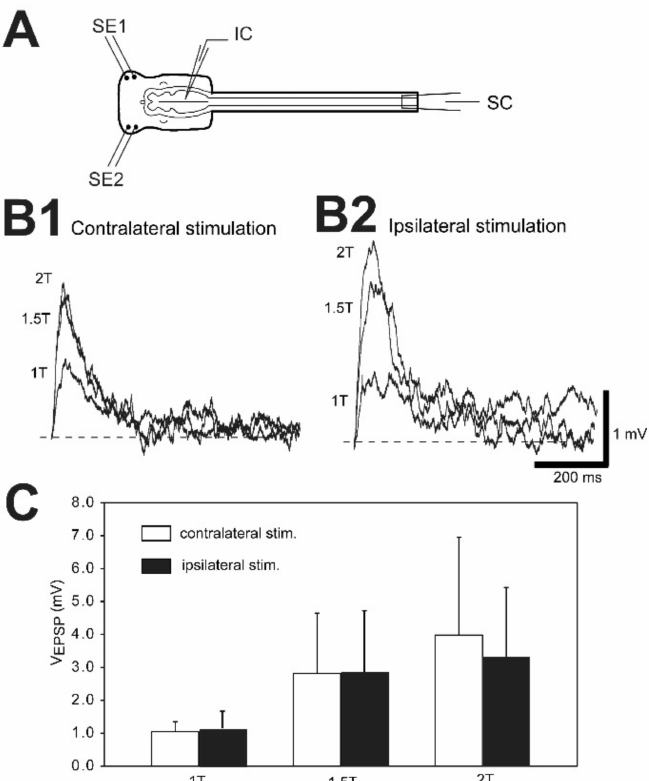
Figure 8. Comparison of contralateral vs. ipsilateral sensory-evoked EPSPs for RS neurons in normal animals. ( A ) Diagram of in vitro brain-spinal cord preparation (not to scale) from a normal animal showing exposed brain (right) and spinal cord (left), intracellular micropipette (IC) for recording from RS neurons, suction electrode (SC) for recording RS neuron-evoked orthodromic action potentials in the spinal cord, and right and left oral hood stimulating electrodes (SE1 and SE2). ( B1 ) Traces of averaged EPSPs evoked in a left “B3” RS neuron (see Figure 1A) by contralateral stimulation of the lateral oral hood (SE1) at various intensities (1 T, 1.5 T and 2 T; see Methods). Horizontal dashed lines indicate V REST . ( B2 ) Traces of EPSPs evoked in the same left “B3” neuron by ipsilateral stimulation of the lateral oral hood (SE2) at various intensities. ( C ) Average amplitudes (bars = means; vertical lines = SDs) of EPSPs recorded from RS neurons evoked by stimulation of the contralateral (open bars) or ipsilateral (filled bars) oral hood at different stimulus intensities (n = 20 RS neurons, N = 9 animals). For each stimulus intensity (1 T, 1.5 T, and 2 T), the contralaterally-evoked and ipsilaterally-evoked EPSP averages were not significantly different ( p = 0.45, 0.95, and 0.47, respectively; unpaired t -test, with Welch correction when appropriate; see